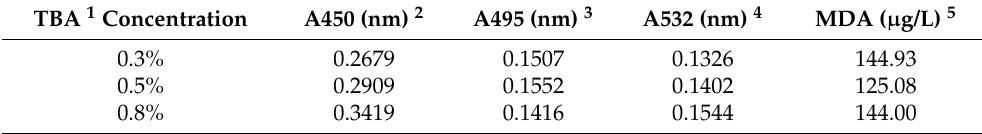
Table 3. The absorbances and MDA concentration with different TBA concentrations ( n =